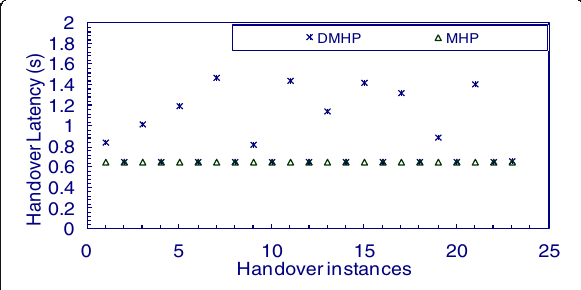
Fig. 11 The first 23 handovers for DMHP and